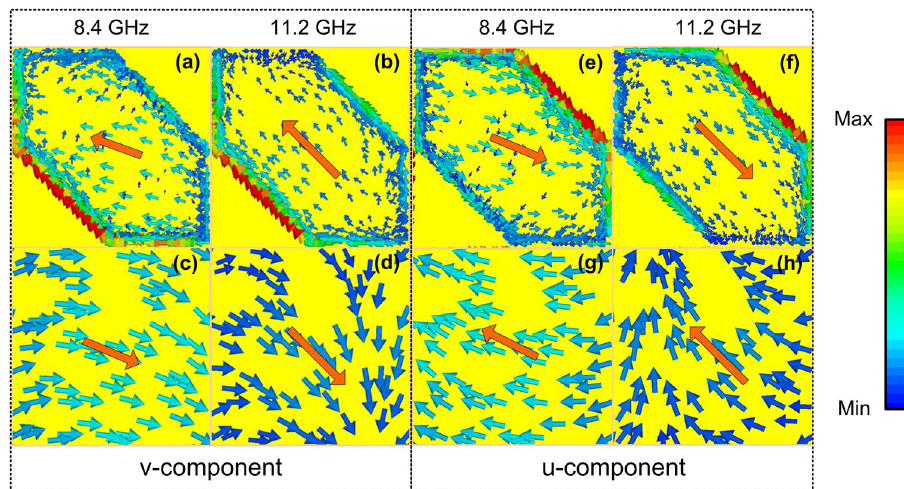
Figure 7. Distributions of surface current on ( a ), ( b ), ( e ), ( f ) the top layer and ( c ), ( d ), ( g ), ( h ) bottom layer of a unit cell for normal incidence in response to the v - and u -components with various resonant frequencies of 8.4 GHz and 11.2 GHz, respectively.